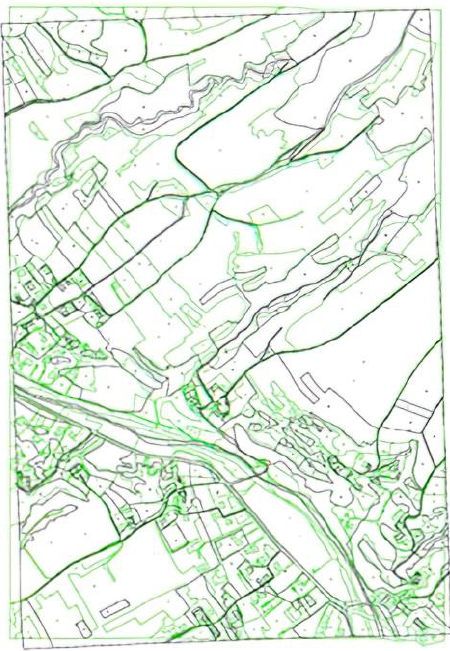
Figure 8. The image created after the vectorization of the orthophotomap from 2010. In the next stage of work, the topology of contoured orthophotomaps was checked. After doing this, both drawings were superimposed to capture the differences that emerged over time. The results of the activities carried out are shown in Figure 9.